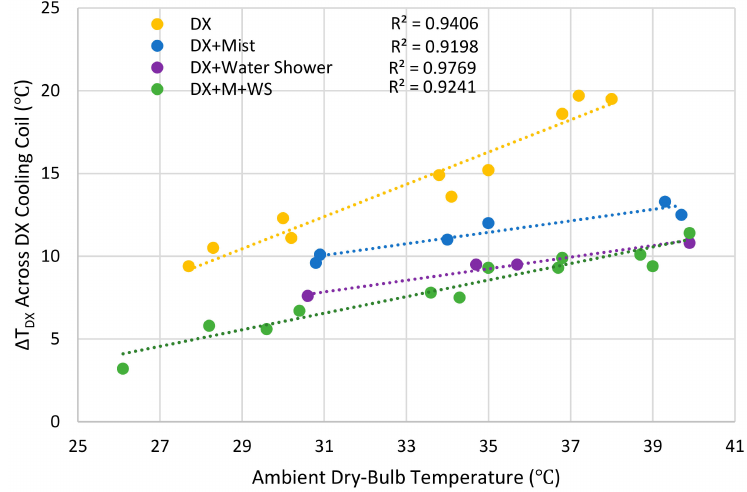
Figure 6. Temperature reduction of primary air across the direct expansion (DX) cooling coil for ambient dry-bulb temperature less than 40 ◦ C.